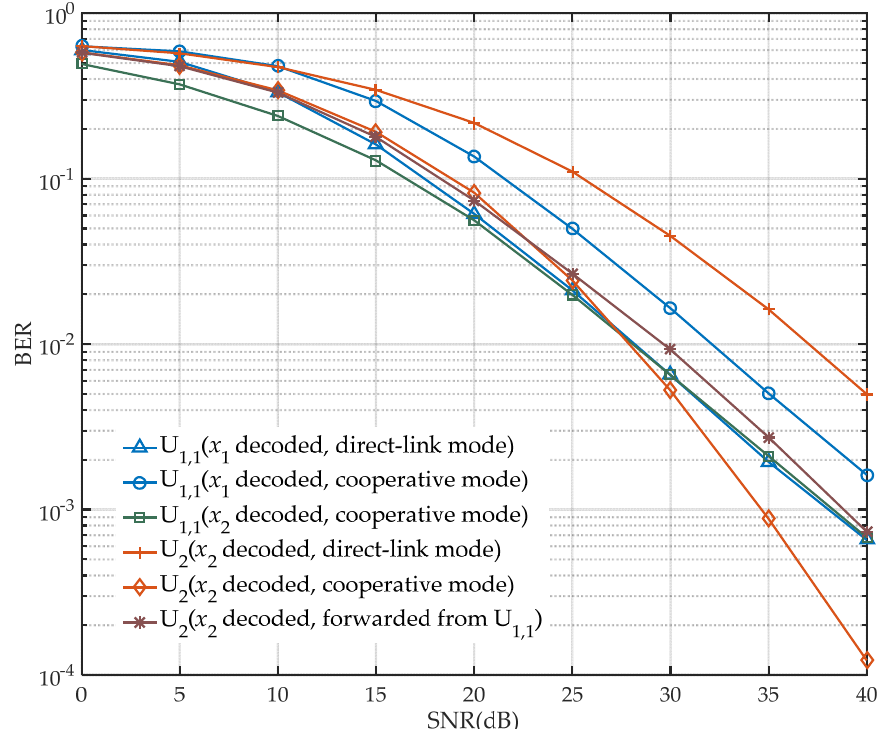
Figure 4. Decoding performance of users after user selection ( P s = 1, a = 0.2, ρ = 0.6 ).